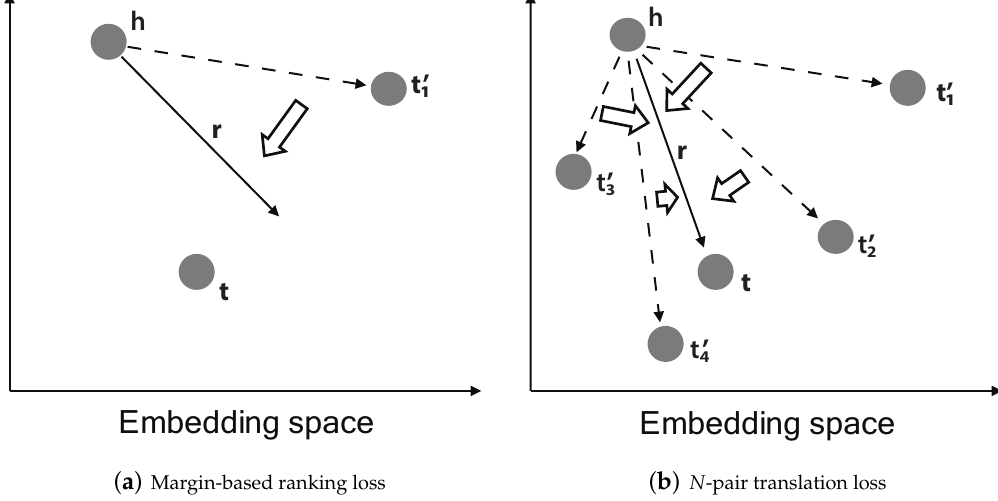
Figure 1. How to find vector representations of entities and relations in TransE. Margin-based ranking loss ( a ) adopts only one negative triple at a time, while N -pair translation loss ( b ) considers multiple negative triples at